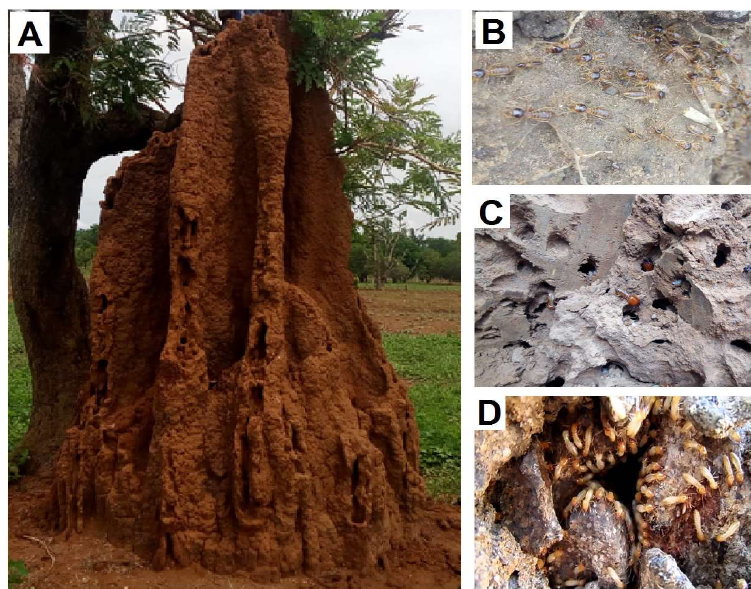
Figure 2. Termite mound and live termite species encountered in the study area. ( A ) Cathedral shaped termite mound, ( B ) Nasutitermes species, ( C ) Macrotermes species, ( D ) Coptotermes species. Bulk Density and Porosity